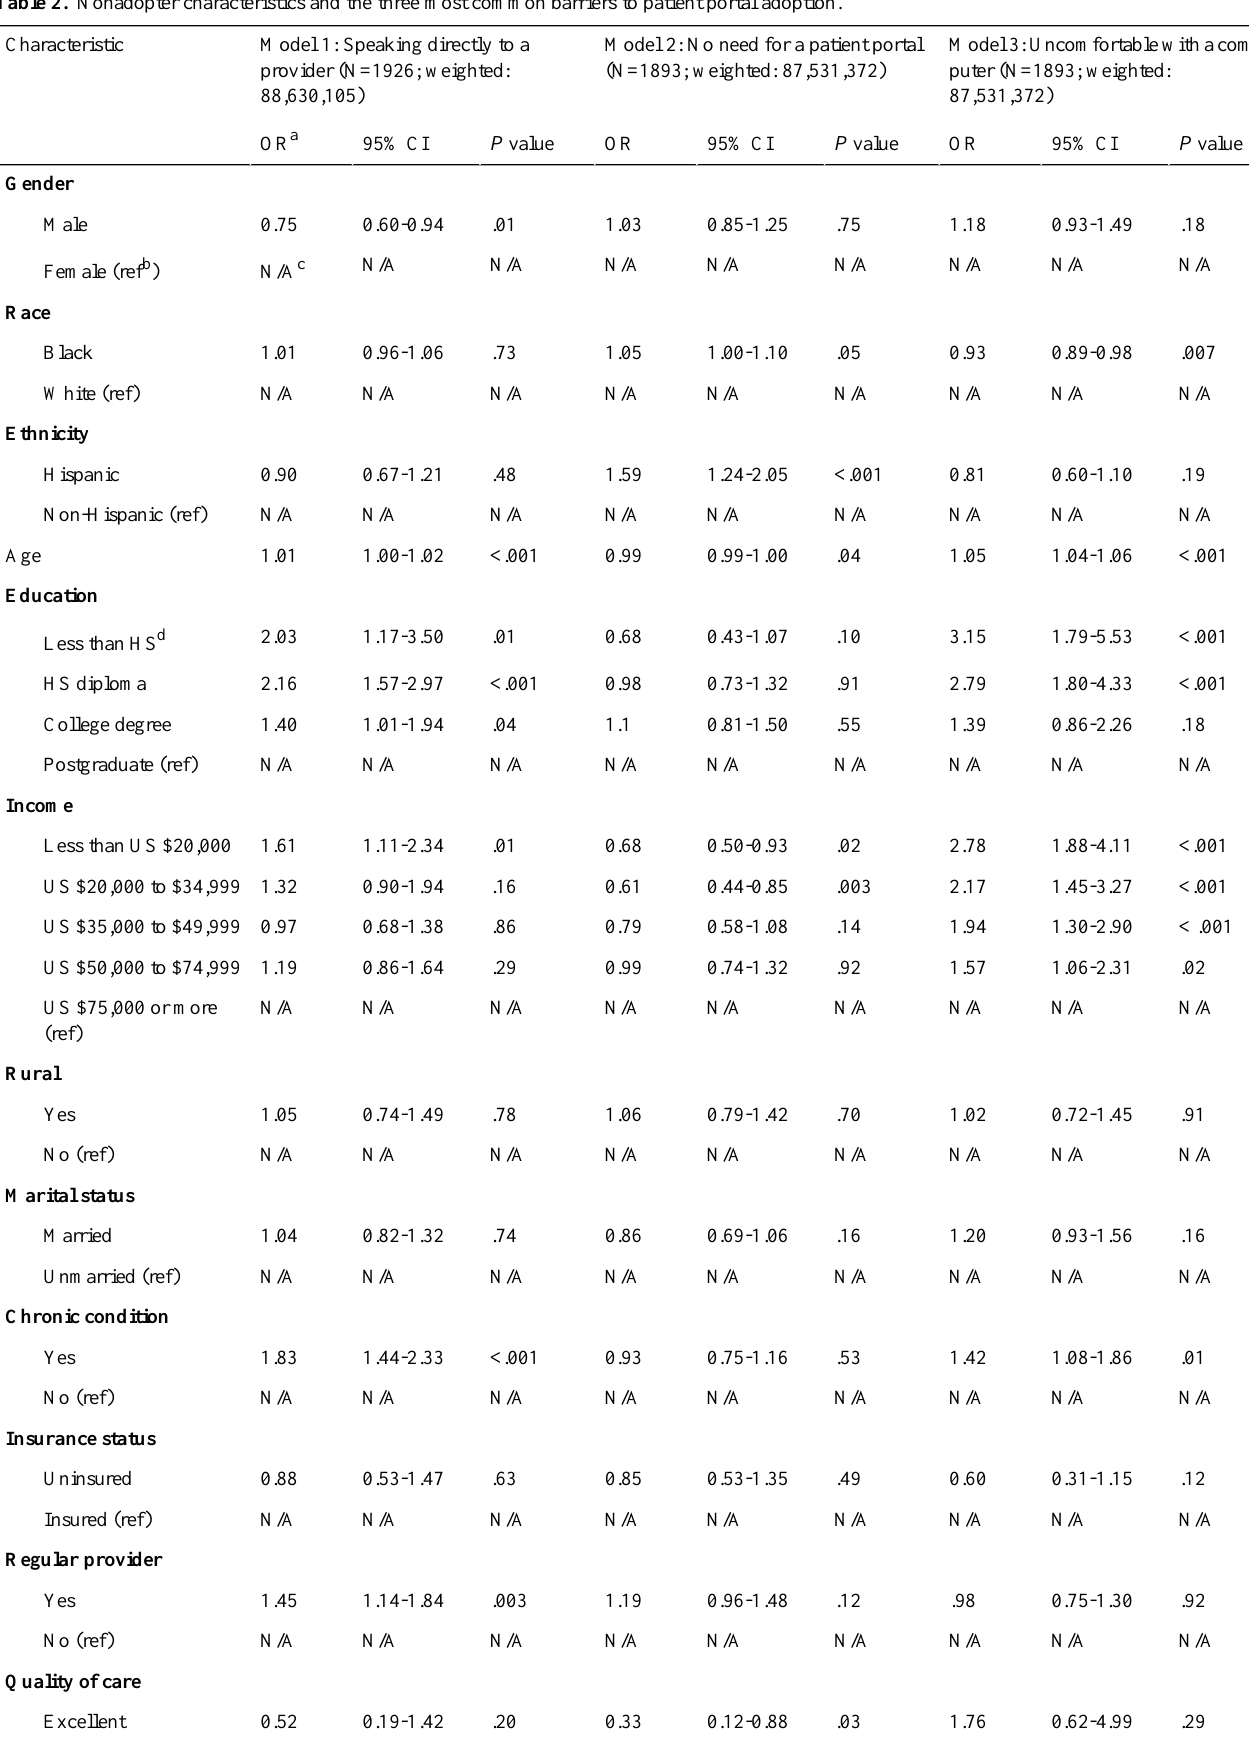
Table 2. Nonadopter characteristics and the three most common barriers to patient portal adoption.